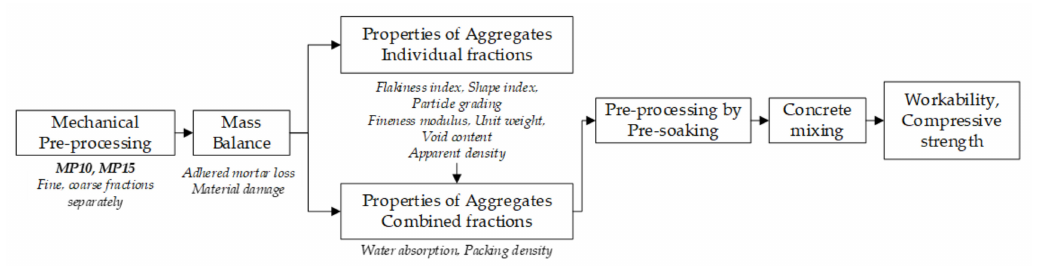
Figure 1. Experimental